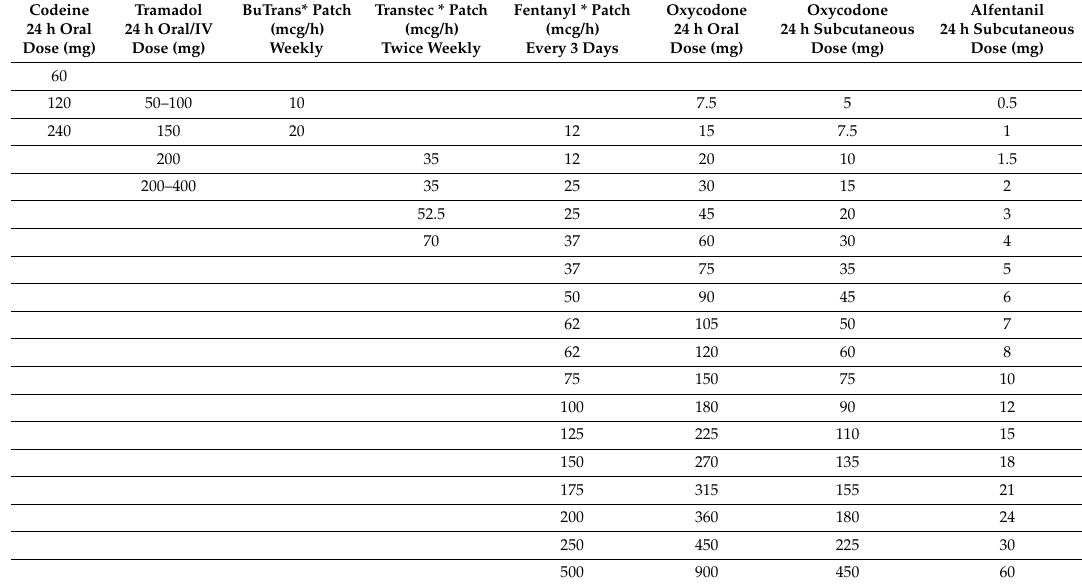
Table 3. Conversion chart for commonly used opioids (* denotes the trade name of drug). Codeine 24 h Oral Dose